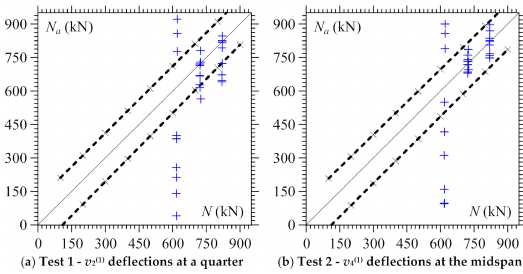
Figure 4. Prestress force determinations N a based on ( a ) Equation (8a) (Test 1) and ( b ) Equation (8b) (Test 2). Symbols + refer to the comparison between determined N a and measured values of prestress force N for all the 27 test combinations. The dashed lines with symbol × represent the sensitivity analyses.